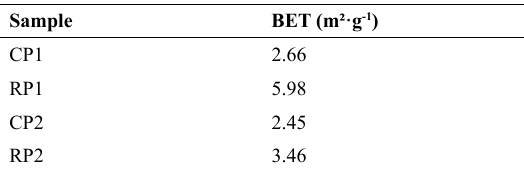
Table 5. Specific surface area (BET) of hemihydrate